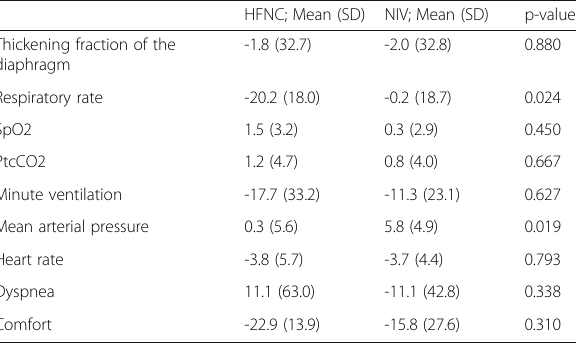
Table 111 (abstract A345). Percentage of change from baseline and 25